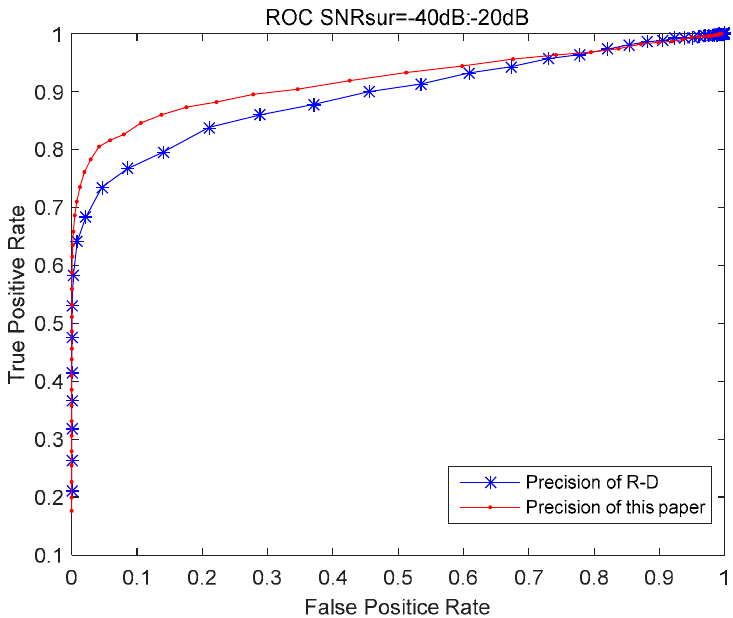
Figure 14. Comparison of ROC curve with SNR ref = 10 dB ( N = 10 4 ) .